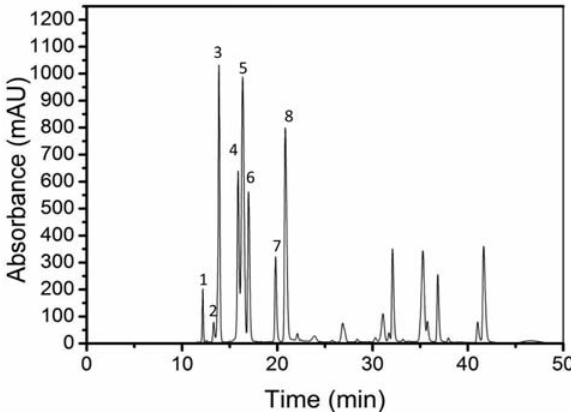
Fig. 1. Chromatogram of anthocyanins recorded at 518 nm. Peak assignation: 1. Delphinidin-3,5- O -diglucoside, 2. Cyanidin-3,5 -O - diglucoside, 3. Delphinidin-3- O -glucoside, 4. Peonidin-3,5- O -di- glucoside, 5. Malvidin-3,5- O -diglucoside, 6. Cyanidin-3- O -gluco- side, 7. Peonidin-3- O -glucoside, 8. Malvidin -3- O